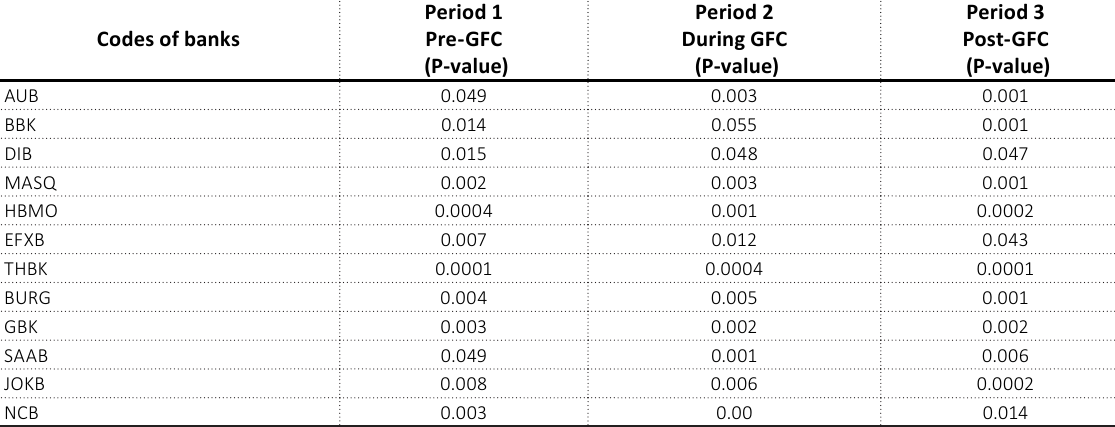
Table 6. Wilcoxon rank-sum test for the emotional words of the anticipation and surprise categories (One Tail Two-Sample)